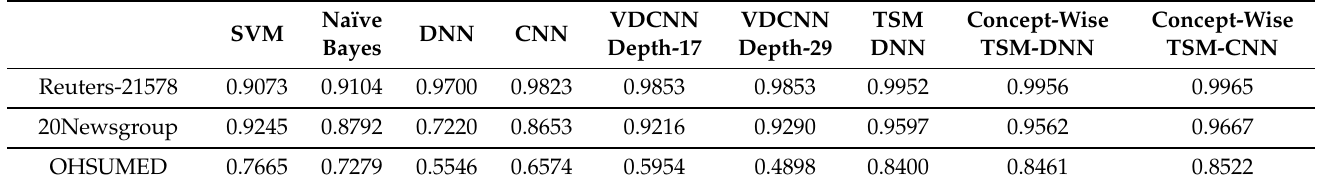
Table 1. Performance comparisons in terms of accuracy.